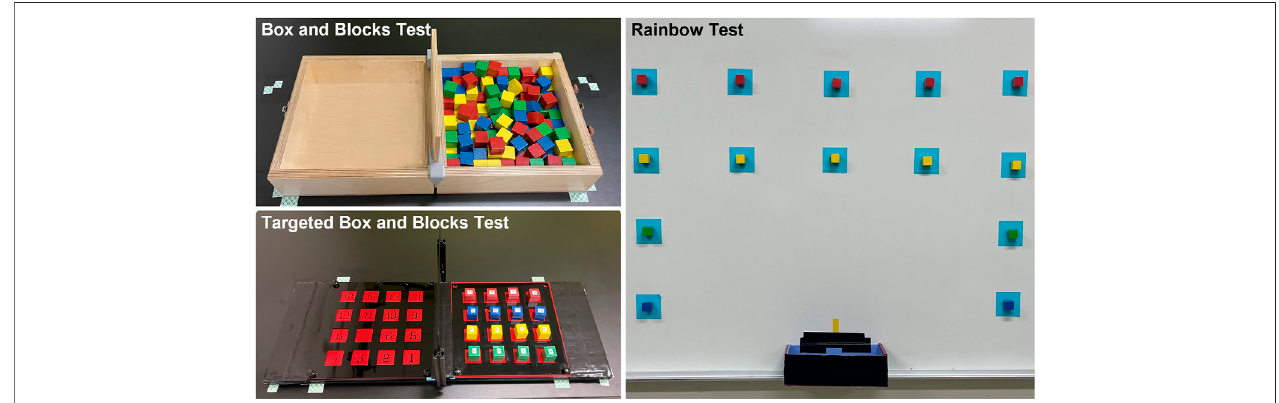
FIGURE 4 | The three functional tasks included the Box and Blocks Test, the Targeted Box and Blocks Test, and the Rainbow Test.